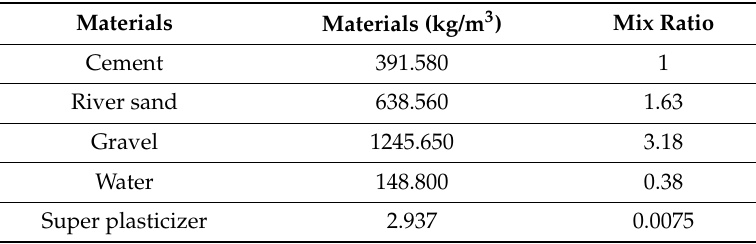
Table 3. Proportion of M30 grade